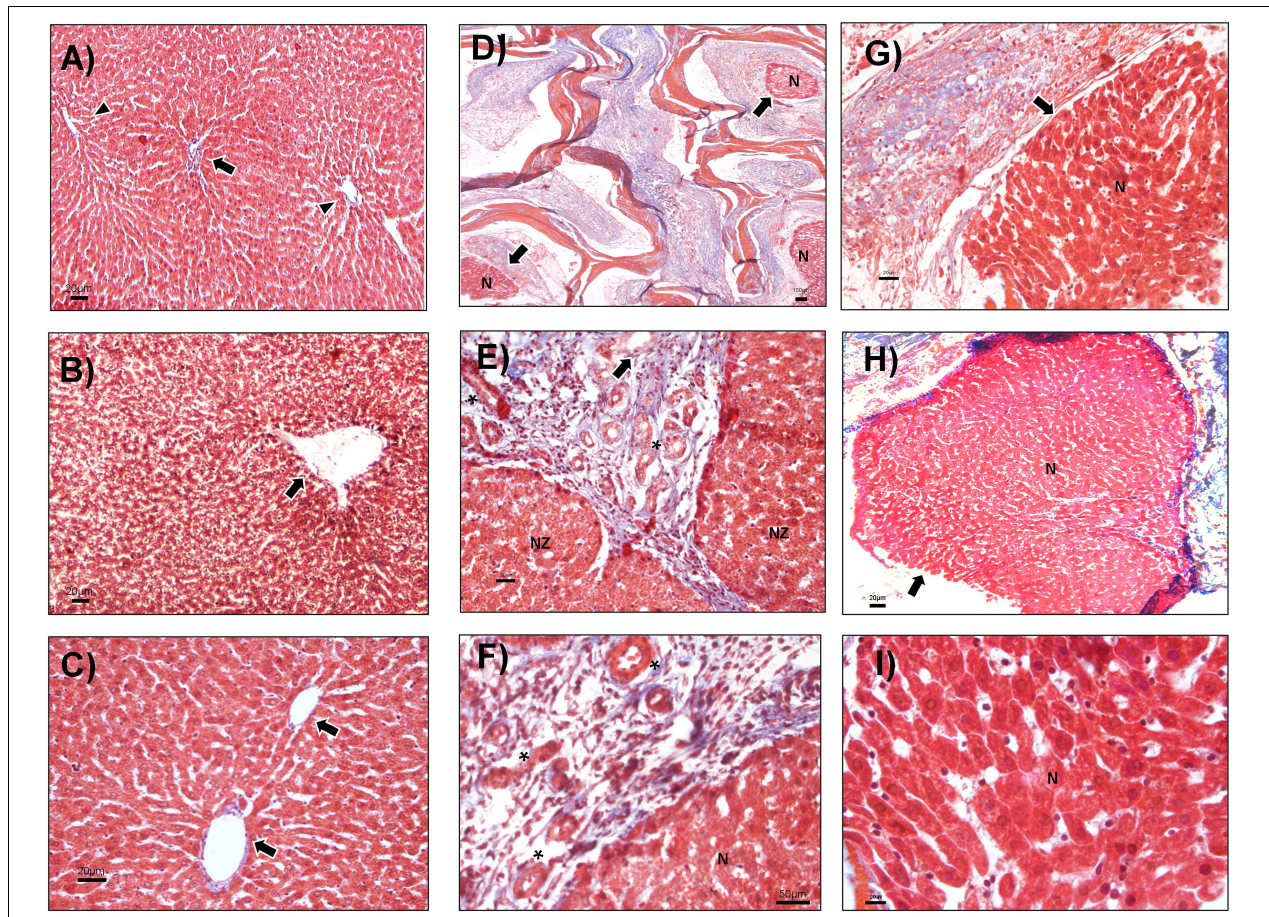
FIGURE 5 | Nodules of the hepatic cell at CMS implantation day 21. (A) The liver without hepatectomy (sham), portal triads (arrow), and central vein (arrowheads), 40 × . (B) PH sample, the central vein is shown (arrow), 100 × . (C) Basal tissue from animals evaluated up to day 21, hepatocyte cords and two central veins (arrows), 100 × . (D–I) PH + CMS implantation at day 21. (D) CMS zone (CZ) and cell nodules (arrows), 40 × . (E) Boundaries between the NZ and the CMS with ductular reaction (arrow), vessels (asterisk) 100 × . (F) Limits between the nodules (N) and CMS, vessels (asterisks), 400 × . (G,H) Nodules of liver tissue (arrow) in the CMS, 10 × . (I) Hepatocytes and Küpffer cells in nodules at high magnification, 400 × . Images with Masson’s trichrome